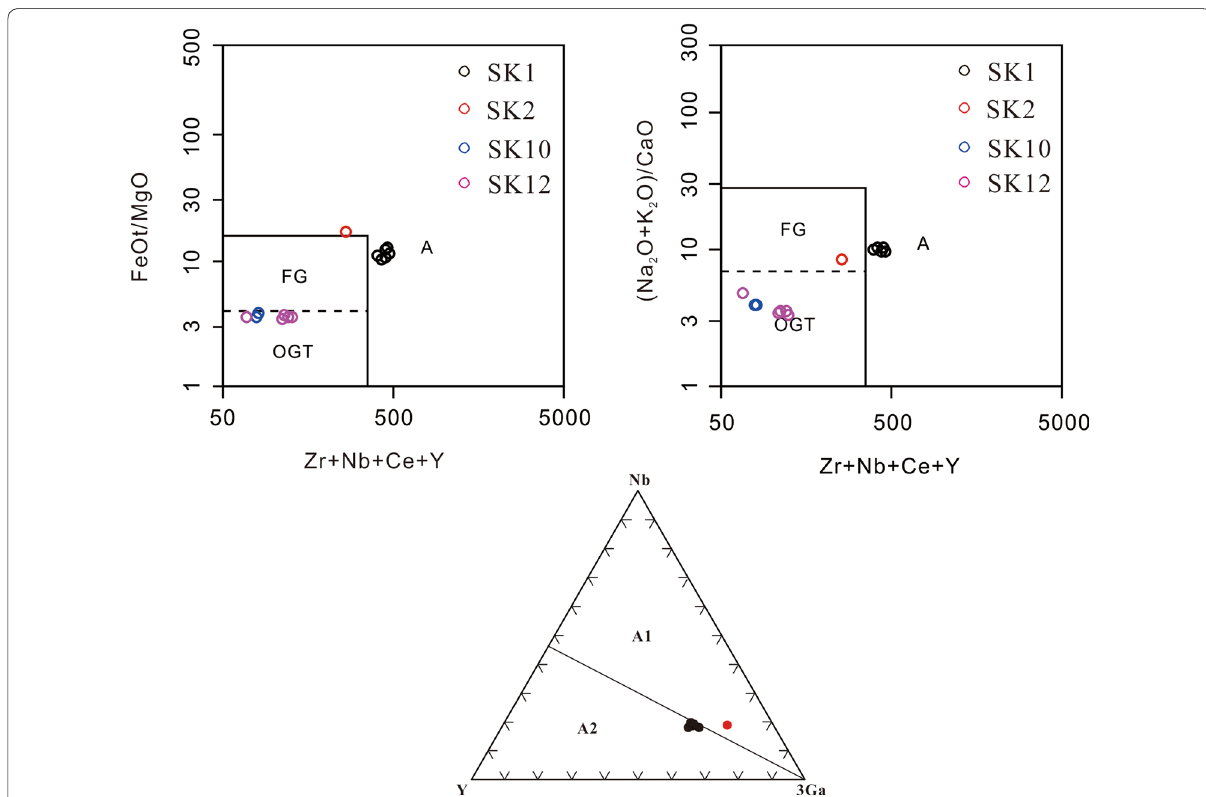
Fig. 13 Granite discrimination diagrams of Whalen et al. (1987). A FG fractionated I-type granitoids. Nb–Y–3 Ga diagram after Eby (1992) for subdivision of A-type granites into A1 and A2 types (see text for =